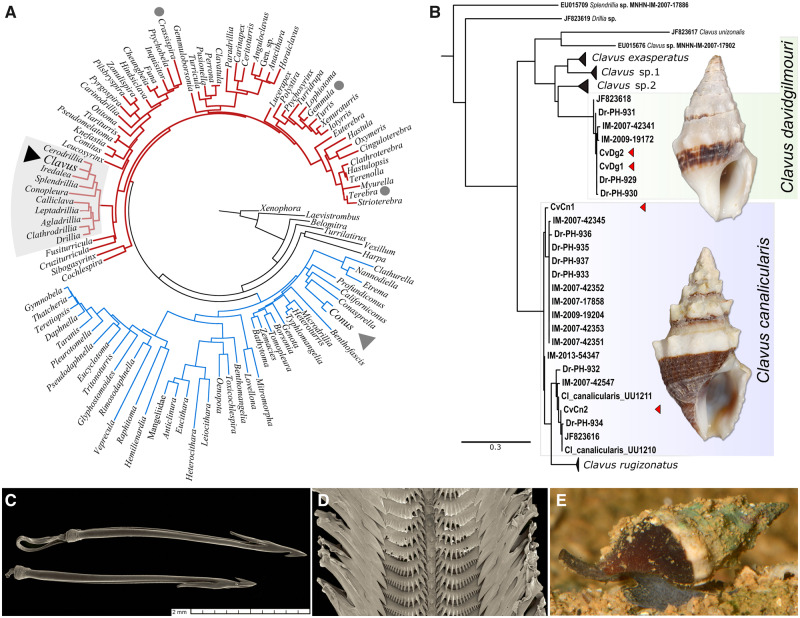
—Phylogeny and morphology of the genus Clavus. (A) Phylogenetic tree of the superfamily Conoidea (after Puillandre et al. 2016). (B) Relationships of the Philippine species of the Clavus canalicularis species complex. (C) Marginal radular teeth of Conus (Pionoconus) circumcisus representing a hypodermic type. (D) Radula of Cv. canalicularis with distinct comb-like lateral teeth. (E) Live Cv. canalicularis (photo—courtesy of David Massemin).